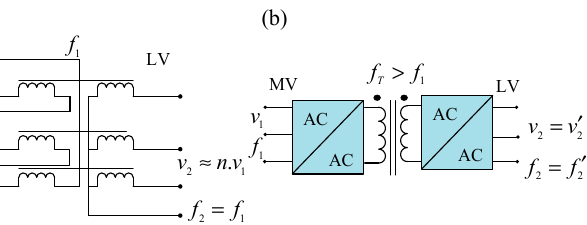
Figure 13. Diagrams of a standard SST: ( a ) low-frequency distribution transformer with a delta-wye connection (LFT), ( b ) SST.